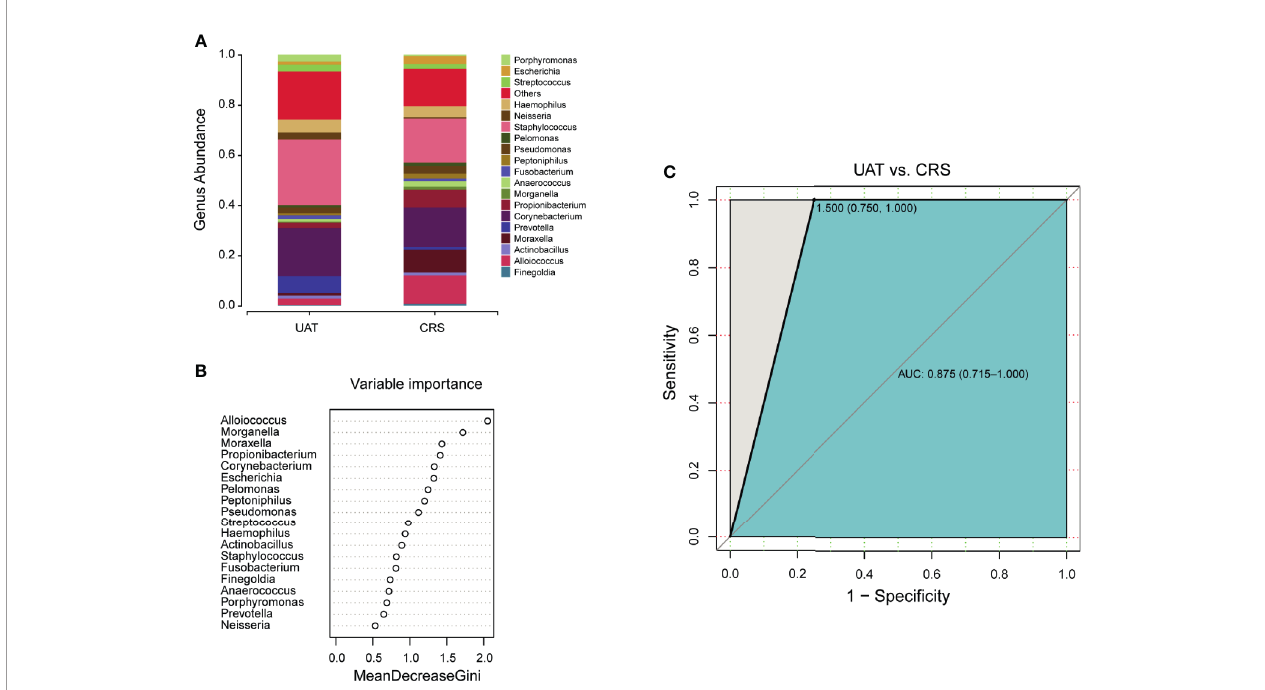
FIGURE 4 | Panelsofnovelmicrobialbiomarkers forUAT-NKTCLdiagnosis. (A) CompositionofthenasalmicrobiotaatthegenuslevelbetweentheUATandCRSgroups(only generawithrelativeabundances>0.5%areshown),and (B) thesetaxa arerankedfrom thetoptobottom bydecreasingGiniindex scoresdeterminedfromtherandom forest algorithmtrainedtodistinguishthe2cohorts. Importantly, thesegenusmarkers incombinationmightbe usedtodistinguishUAT-NKTCLfrom CRS, (C) achieving anAUCof 0.875 (95%CI:0.715to1.0). UAT, upperaerodigestivetract; CRS,chronicrhinosinusitis;AUC,areaunder the curve;95%CI, 95%con fi